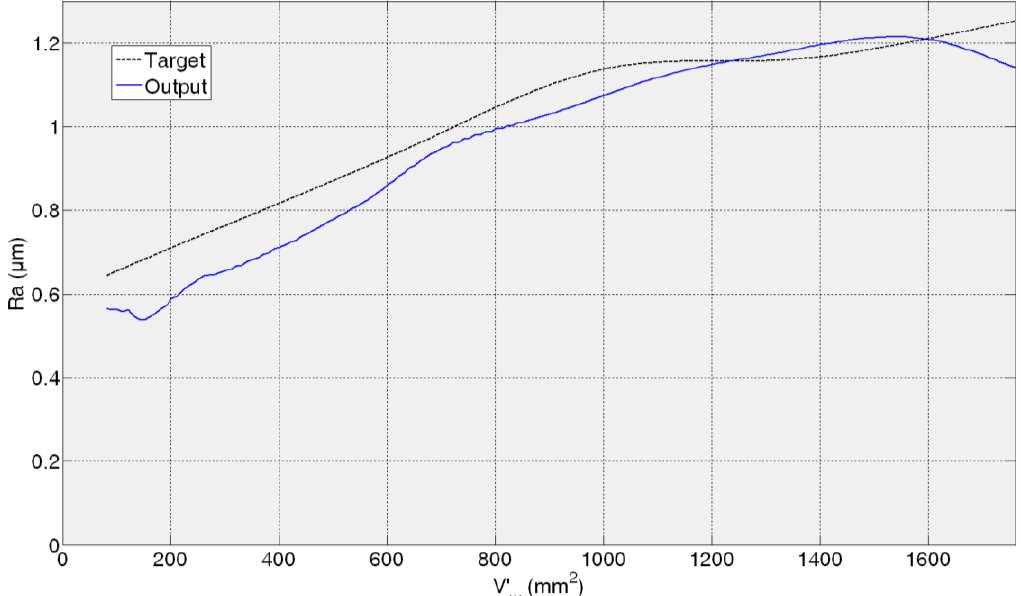
Figure 13. R measurement for 82AA36G6VW wheel, q a process variables.